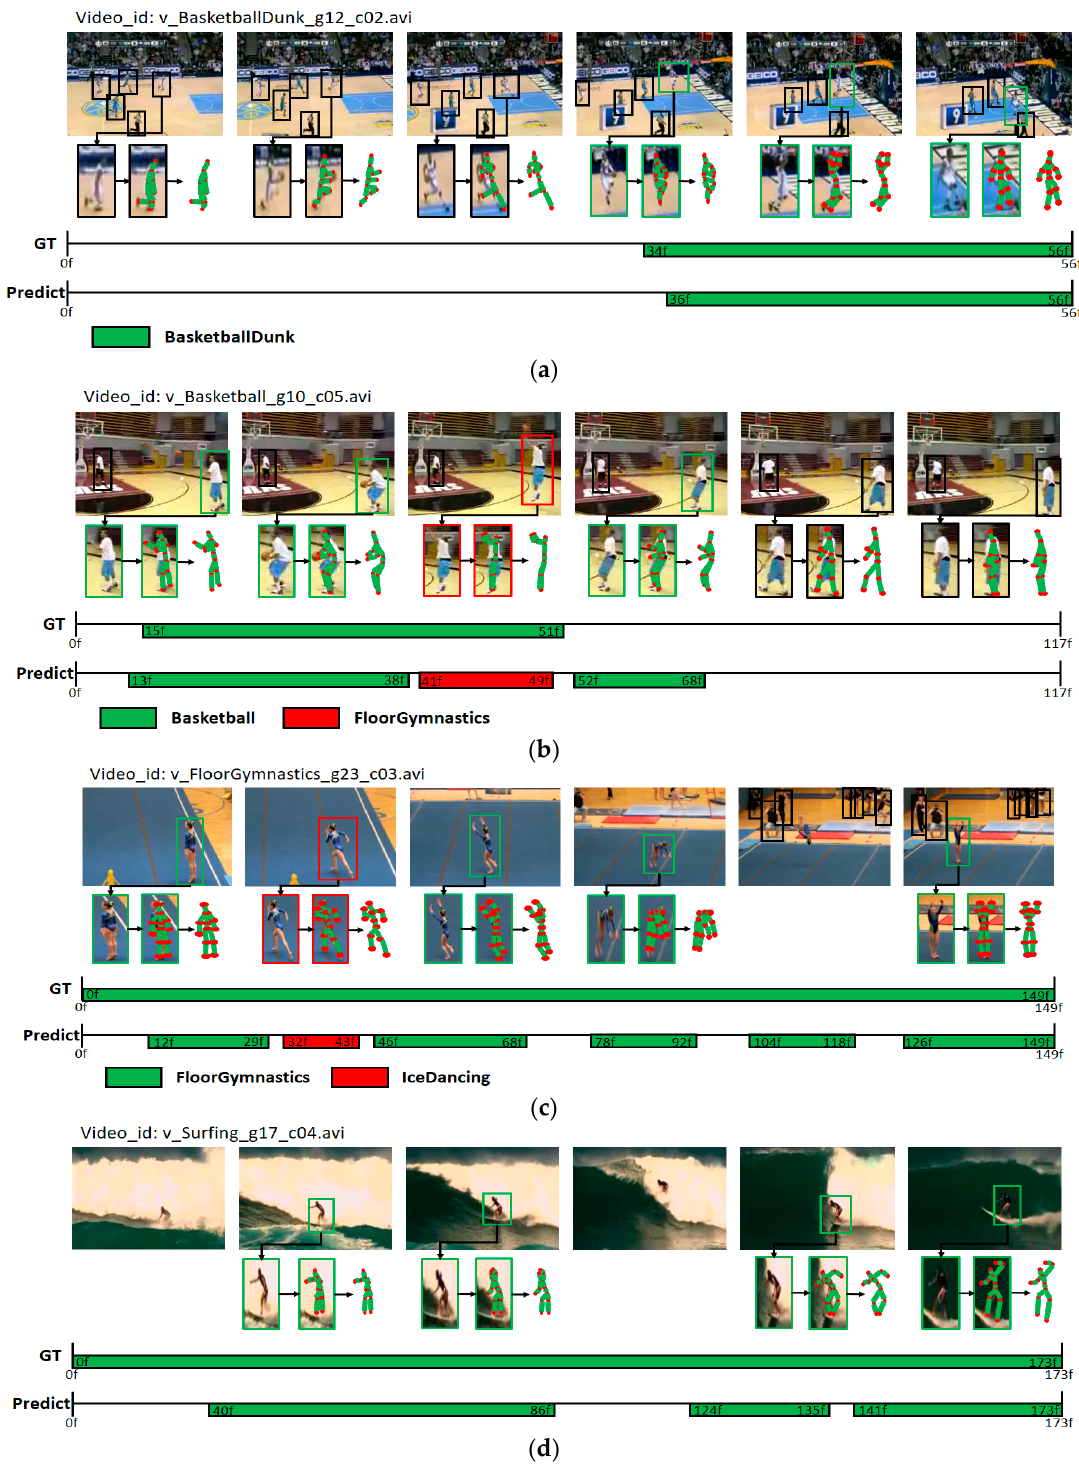
Figure 8. Visualization of action-detection results by using the spatio-temporal action-detection model; UCF-101. Figure ( a – d ) show results for videos each in UCF-101(24 classes). Ground truth activity segments (GT) are marked in green on the top line. Predicted activity segments (Predict) are marked in green for correct predictions and in red for wrong ones on the bottom line.